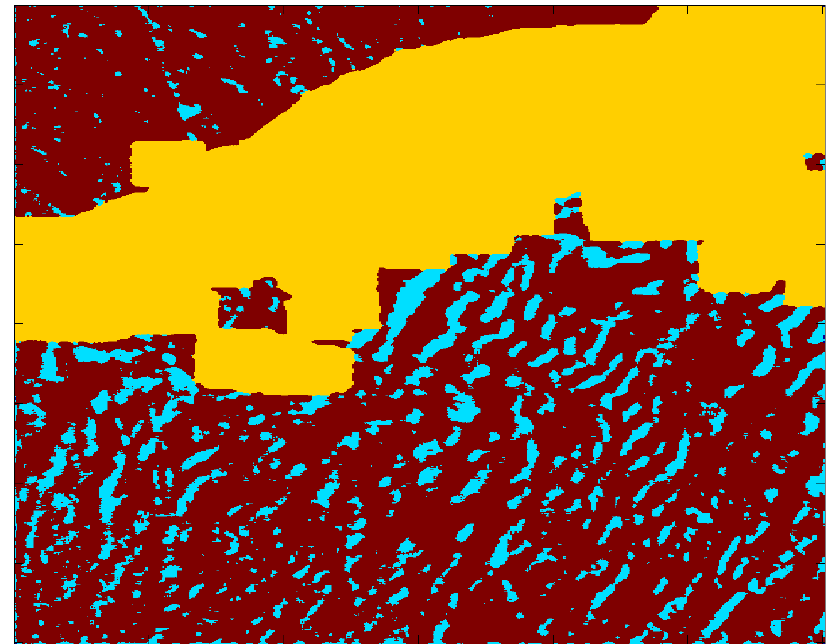
Figure 10. Despeckled cluster membership image for the case study, 0426 UTC on September 1, 2006. Each color represents points belonging to a common cluster. The fourth cluster was eliminated by the despeckling operation.